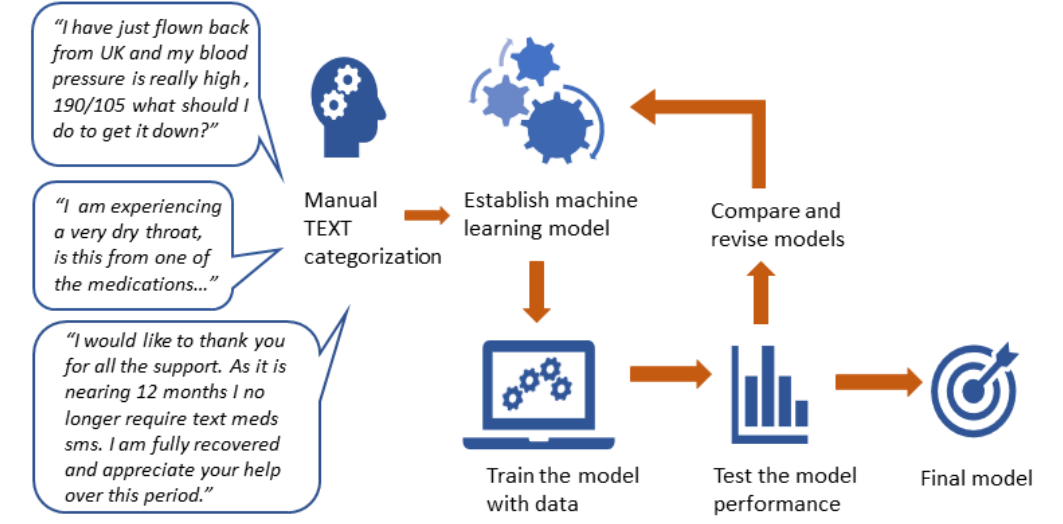
Figure 1. Machine learning model development and